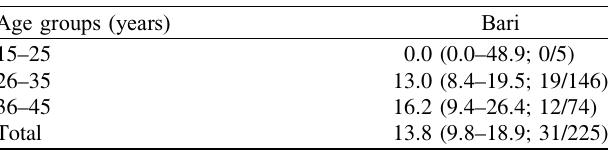
Table 2. Prevalence of anti- T. gondii IgG in samples collected from pregnant women in Bari (2016 – 2017), divided by age groups (%, 95% CI;